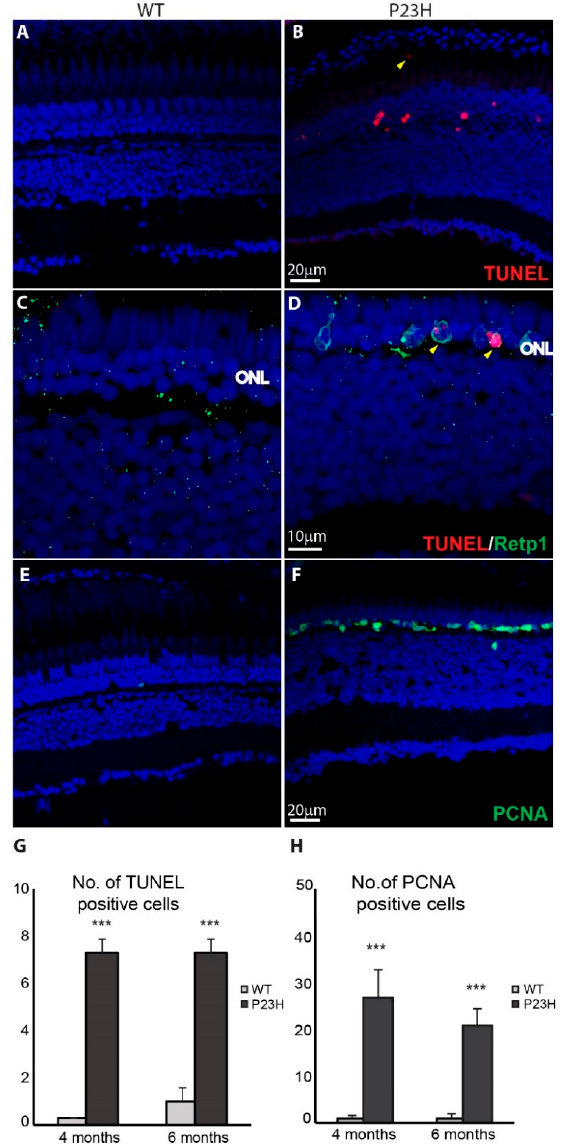
Figure 5. Cell death and cell proliferation in the P23H transgenic zebrafish. ( A , B ) Cell death detection using TUNEL staining shows TUNEL-positive dying cells (red) in the P23H zebrafish retina (4 months old). The yellow arrowhead shows a TUNEL-positive cell in the sub-retinal space. ( C , D ) Yellow arrowheads show the colocalization of Retp1 (green) with TUNEL labeling in the P23H transgenic fish. ( E , F ) PCNA immunostaining shows many PCNA-positive proliferating cells (green) in the ONL of the P23H zebrafish, but very few in WT. ONL: outer nuclear layer. ( G ) Numbers of TUNEL positive cells and ( H ) PCNA-positive cells per 210 µ m image field in 4-month old and 6-month old WT and P23H retina (n = 6 fish per genotype; error bars are ± SD; *** p <